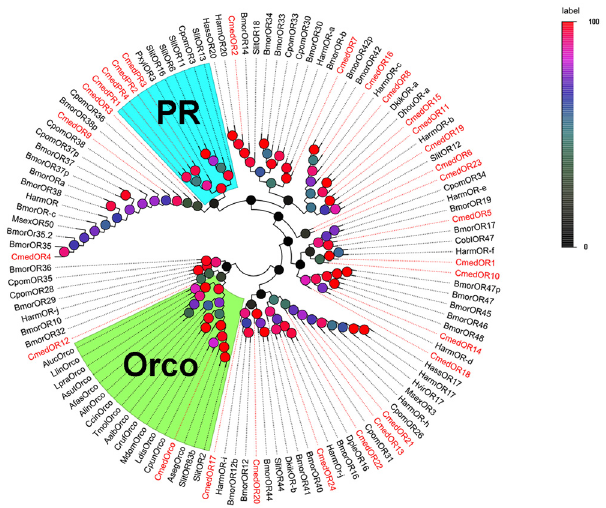
Sensory neuron membrane proteins (SNMPs), which are located in the dendritic membrane of primarily pheromone-specific OSNs, are thought to trigger ligand delivery to the receptor [32]. The two ‘ discovered ’ SNMPs share 100% sequence similarity with those reported previously [51]. The putative IR genes in the C . medinalis antennal transcriptome can be represented according to their similarity to known insect IRs. Bioinformatics analysis led to the identifica- tion of 15 IR candidates, in which three sequences contained a full-length ORF, and the remaining 12 sequences were fragments. Insect IRs have three trans-membrane domains, and TMHMM2.0 predicted the six candidates C . medinalis IR also have three trans-membrane domains (Table 4). For phylogenetic analysis, 13 of the putative C . medinalis IRs were aligned with orthologous IRs from D . plexippus , B . mori , S . Littoralis , and D . melanogaster , the